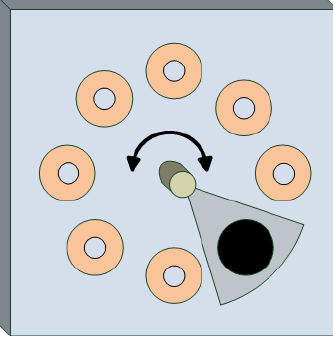
Figure 1. Pendulum-based non-resonant energy harvester devel- oped by Spreemann et al. (2009).